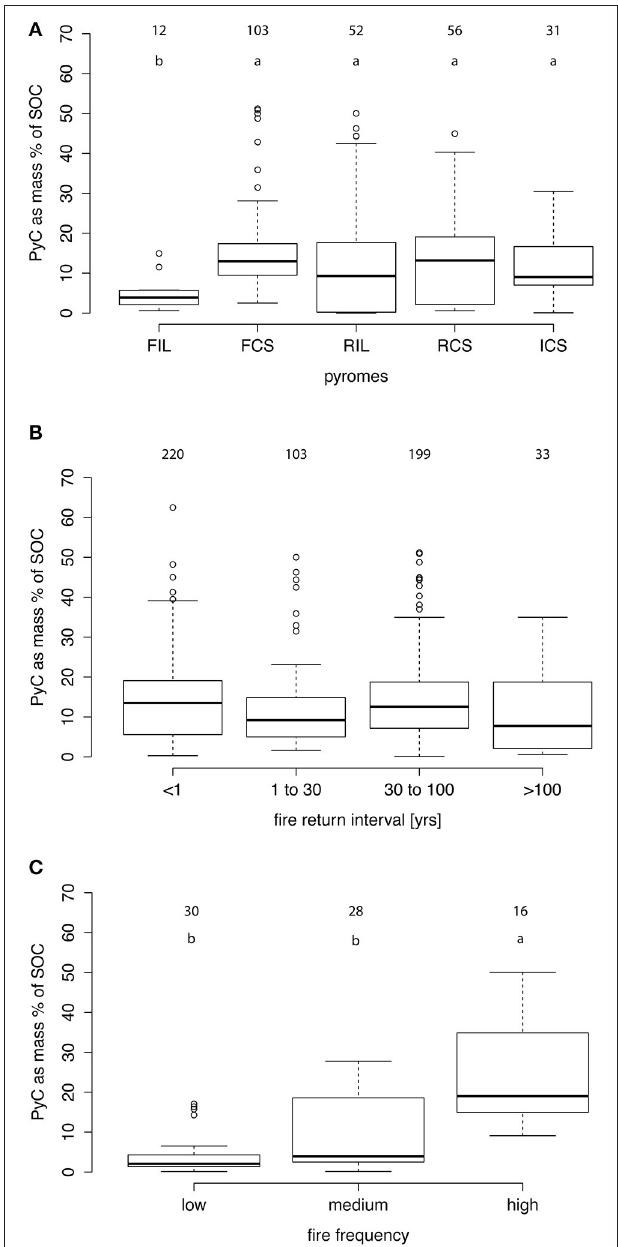
FIGURE 4 | PyC content as mass % of the total SOC described by fire parameters: the pyromes of Archibald et al. (2013) (A); global fire return interval (B); on-site fire-frequency information (C). One-Way-ANOVA results in p < 0.001, < 0.001, and 0.19 for the pyromes, the global fire return interval, and on-site fire frequency, respectively. The different letters on the top indicate significant differences ( p < 0.05) within the datasets.